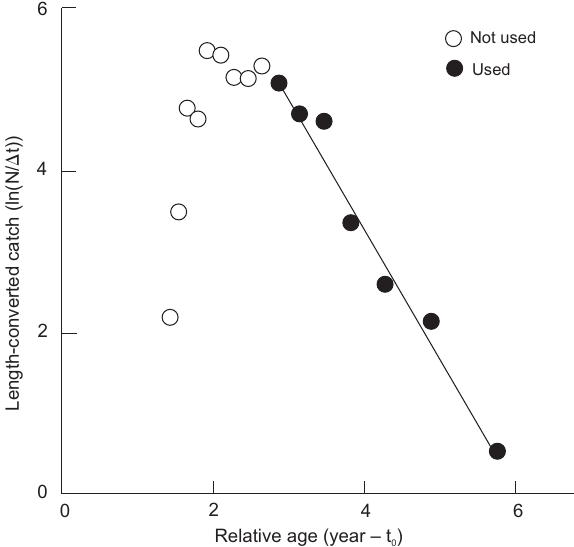
Figure 8. Length-converted catch curve for all yellowfin tuna speci- mens collected from the eastern and central Pacific catch samples from February to November 2006. “Not used” indicate the data refer to length classes not fully recruit to